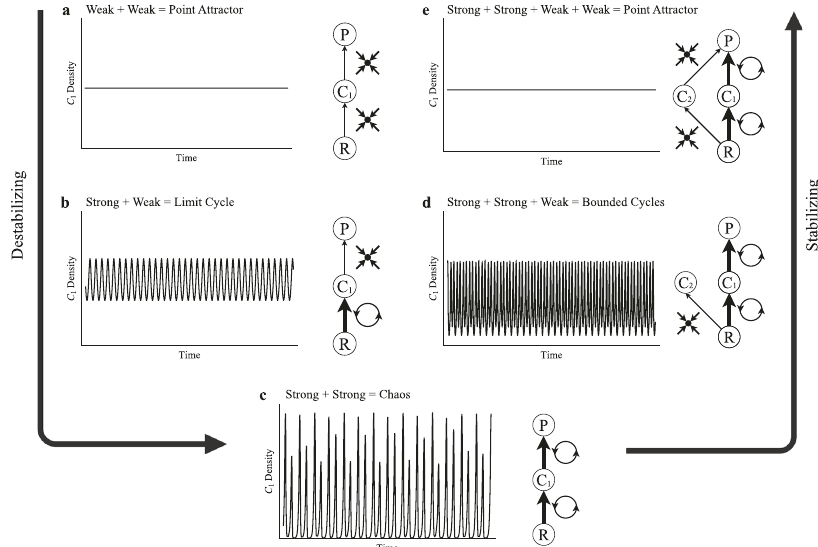
Fig. 3 Algebra of C – R modules. Time series showing the general dynamical outcomes for the food chain and diamond module at steady state with varied combinations of C – R interaction strengths. a Weak – weak interaction; point attractor. b Strong – weak interaction; limit cycle. c Strong – strong interaction; chaos. d Strong – strong, weak interaction; limit cycle. e Strong – strong, weak – weak interaction; point attractor.